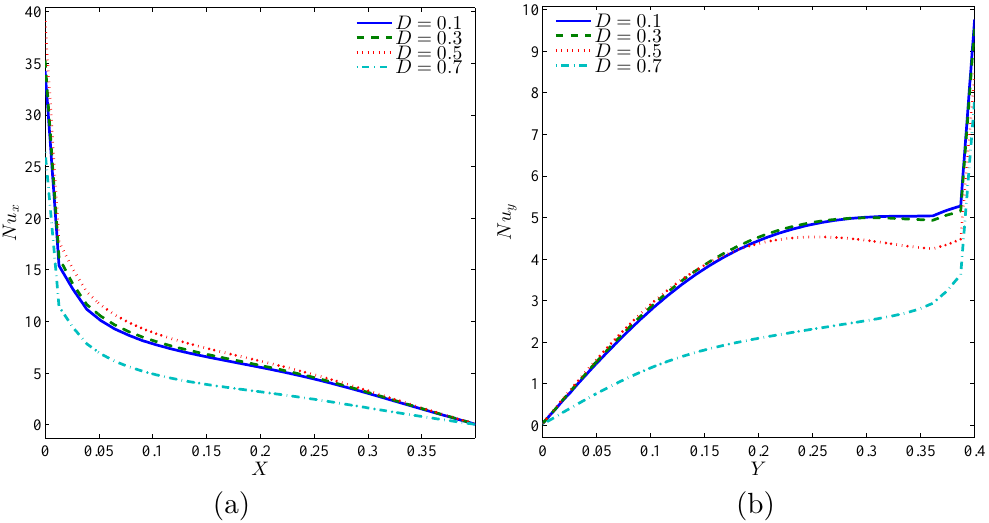
Figure 13. Variations of the local Nusselt numbers along ( a ) the bottom side wall ( X ) and ( b ) the left side wall ( Y ) for different D at Ra = 10 5 , φ = 0.02 and k w =